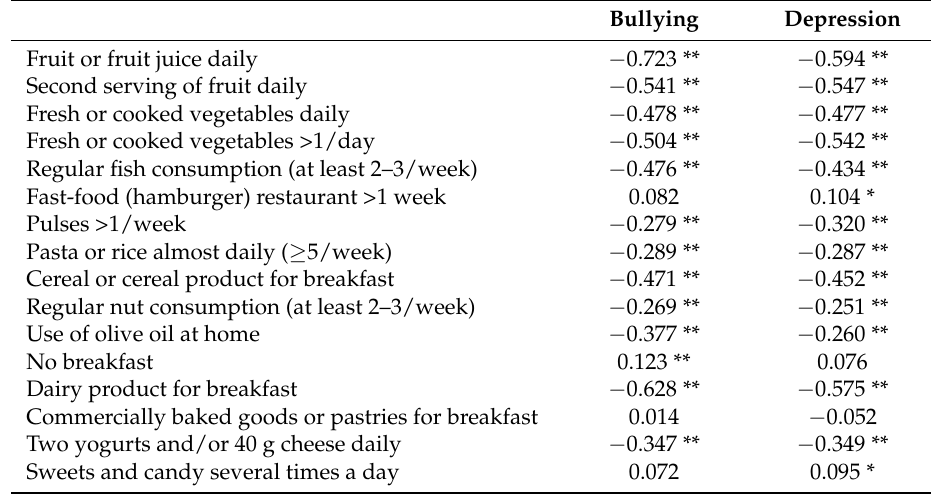
Table 1. Pattern of Pearson’s correlations between bullying, depression, and dietary habits (* p < 0.05; ** p < 0.001).